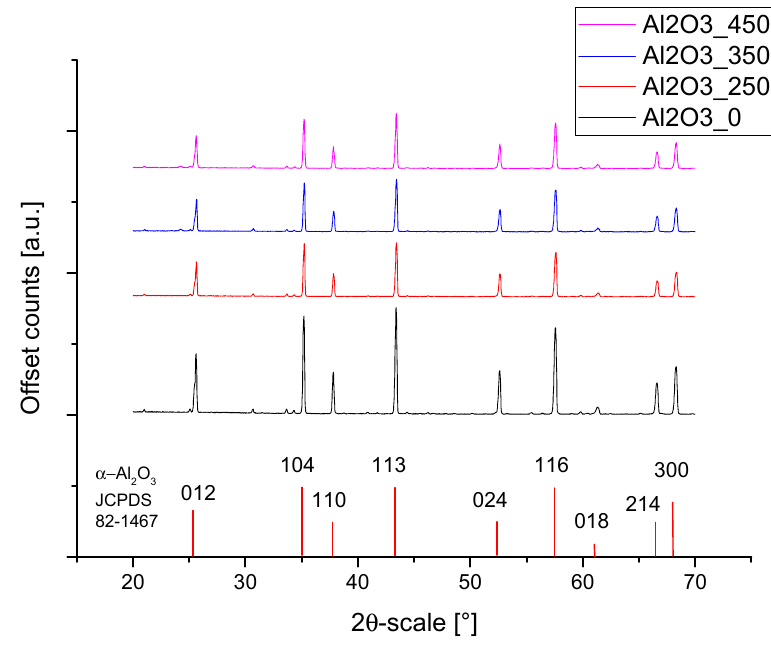
Figure 2. XRD patterns of heat-treated and APTES surface modified alumina.